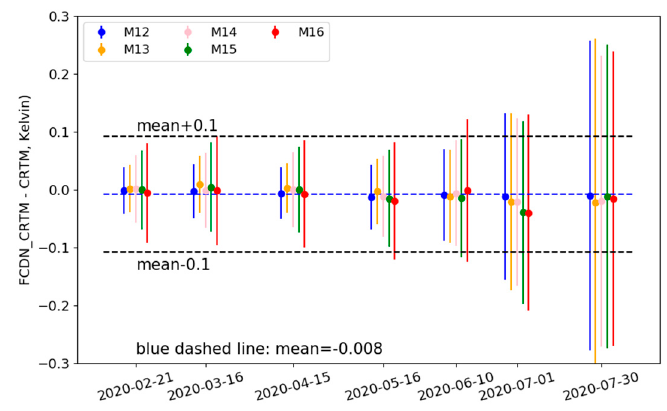
Figure 8. The error bars of FCDN_CRTM minus CRTM from M12 to M16 for seven dispersion days from February to July, 2020. The VIIRS Clear-sky pixels were identified by FCDN_CSM. The blue dashed line represents the mean for the data of all seven days.